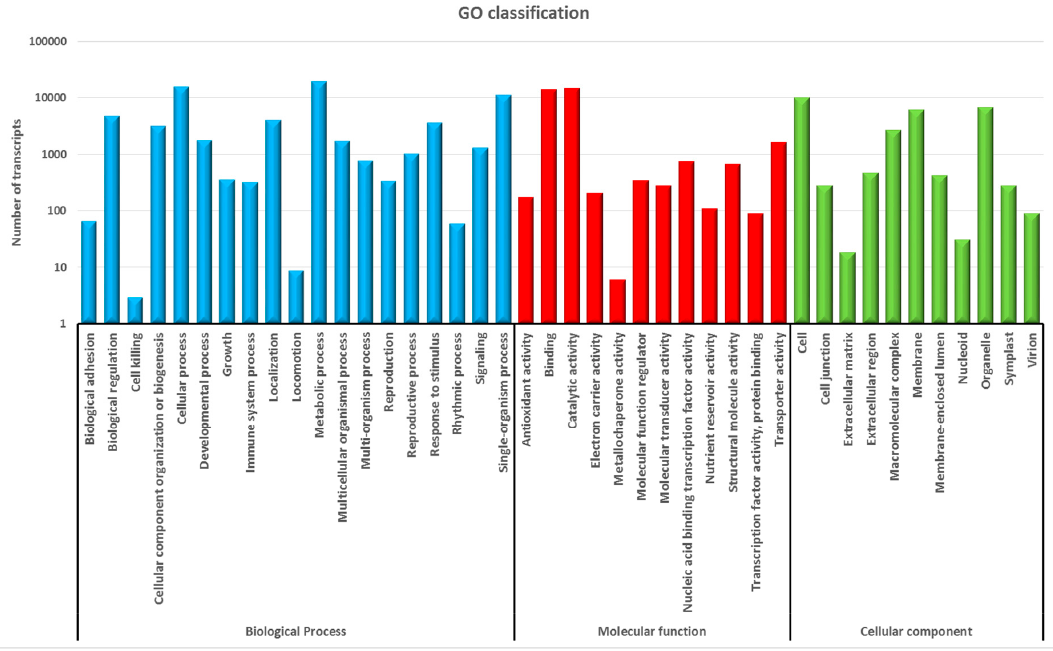
Figure 2. Functional annotation of assembled Cassab-derived reference transcripts based on gene ontology (GO) categorisation: GO analysis was performed at the level 2 for three main categories (biological process, molecular function, cellular component).